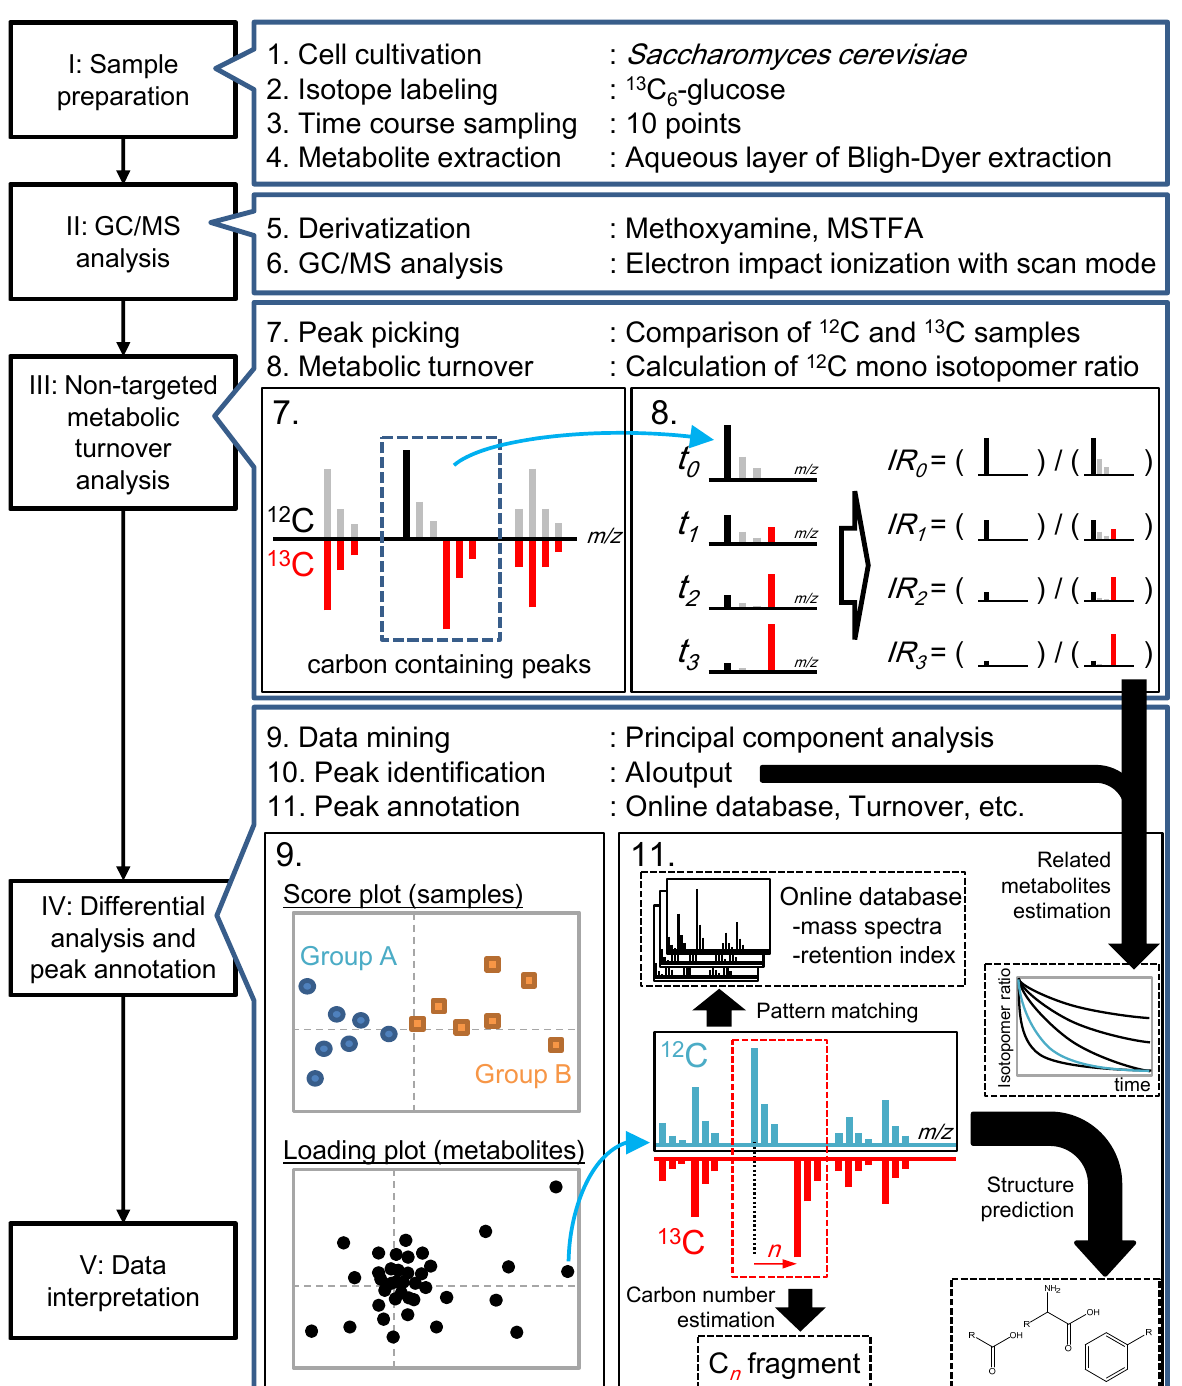
Figure 1. Non-targeted metabolic turnover analysis-based differential analysis of metabolic dynamics. Boxes on the left indicate the workflow of gas chromatography/electron ionization/mass spectrometry (GC/EI/MS)-based non-targeted metabolic turnover analysis. Procedural details are described in the boxes to the